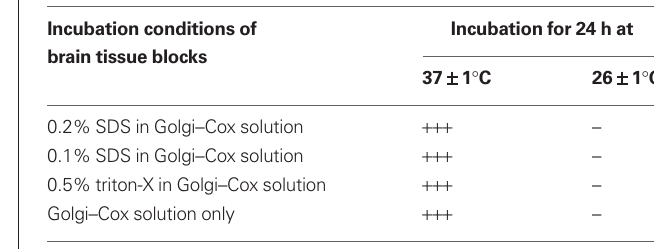
Table 1 | Completely filled neurons in 200 μm thick sections prepared from 5 mm brain blocks treated under various